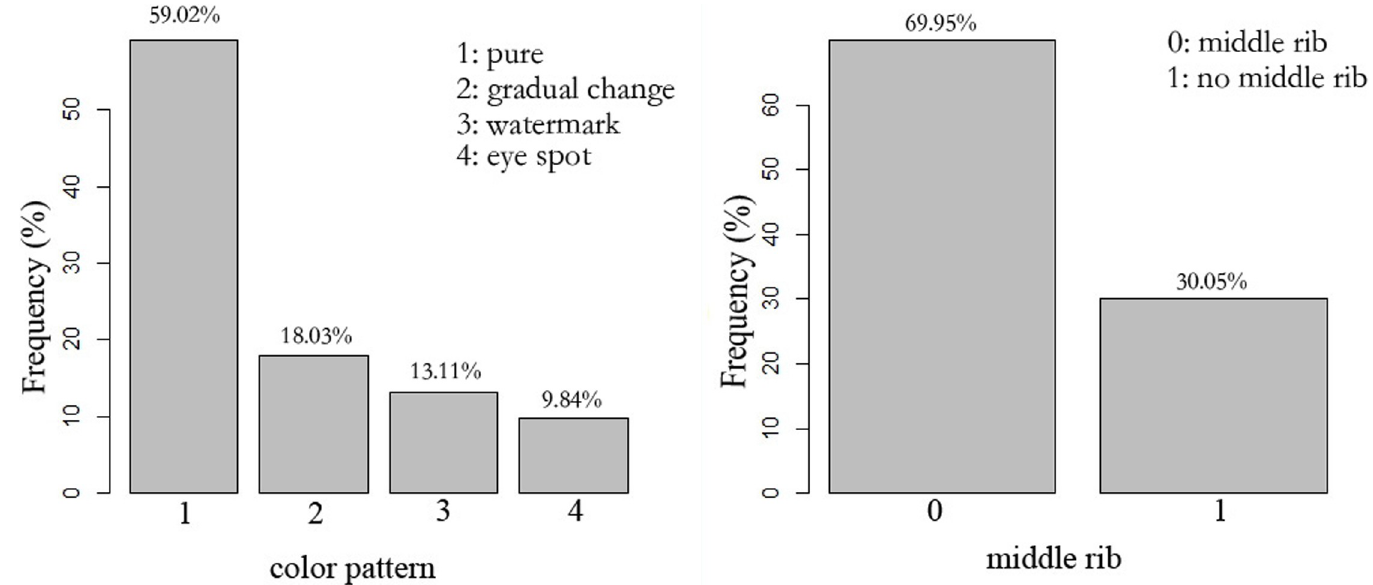
Fig 2. The distribution ratio of color pattern of